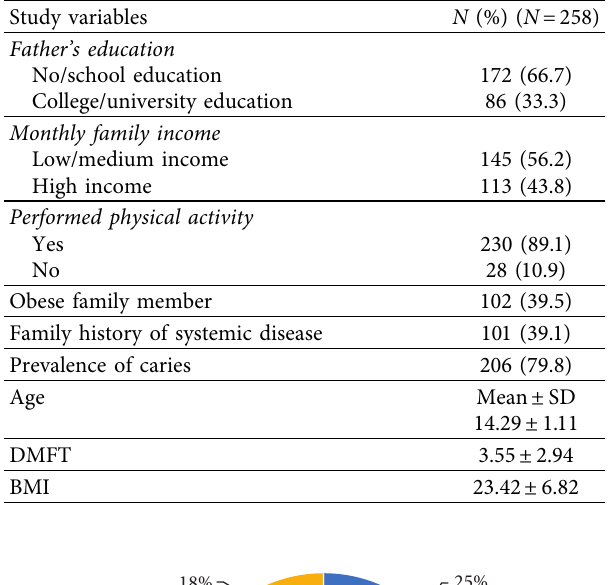
Table 1: Characteristics of study participants.